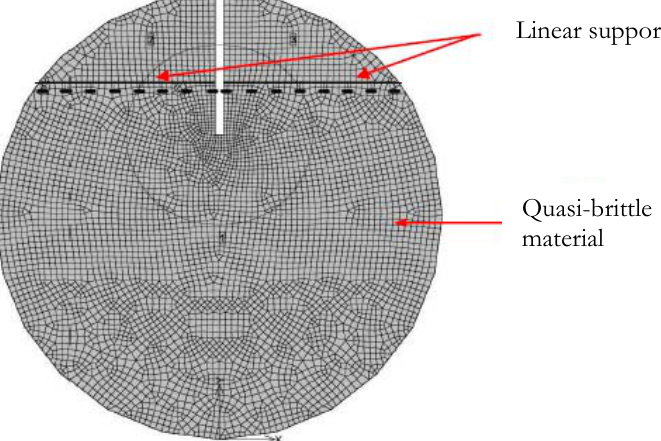
Figure 4: Mesh and boundary conditions used for model 1.